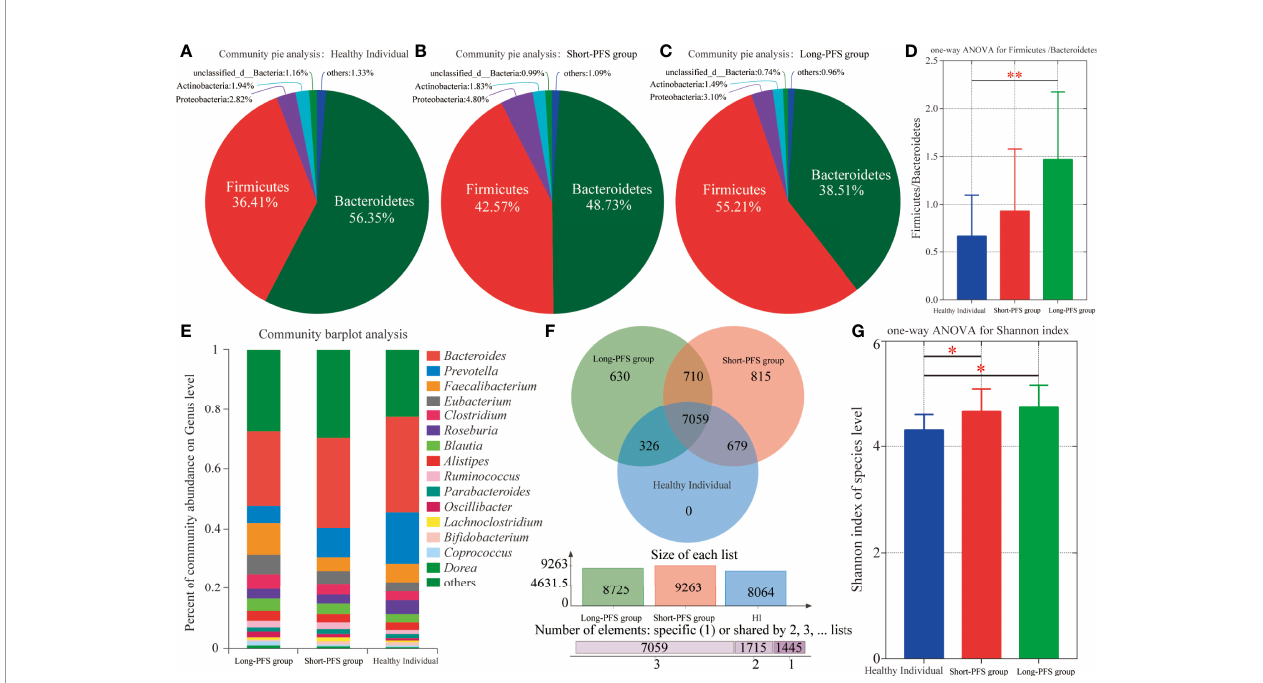
FIGURE 1 | Intestinal microbiota composition among long-PFS group, short-PFS group and healthy individuals (HI). (A-C) The community pie analysis at phylum level for HI, short-PFS group and long-PFS group, respectively. (D) The one-way ANOVA of the Firmicutes/Bacteroidetes ratio among three groups. (E) Stacked bar plots depicting genus-level differences in gut microbiota composition. (F) The venn diagram analysis among three groups at species level. (G) Comparison of microbial alpha diversity (shannon index) among three groups. *P < 0.05, **P < 0.01.